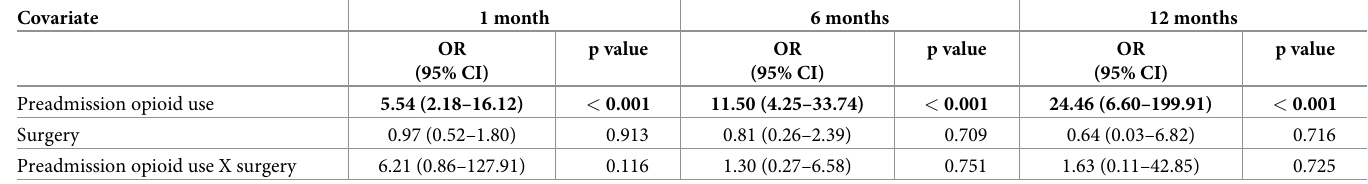
Table 4. Generalized linear model comparing the effect of preadmission opioid use and surgery on persistent opioid prescription 1, 6 and 12 months post- discharge. Covariate 1